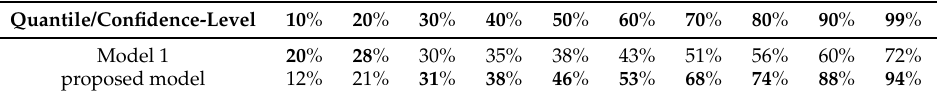
Table 1. Accuracy comparison between Model 1 and the proposed model.